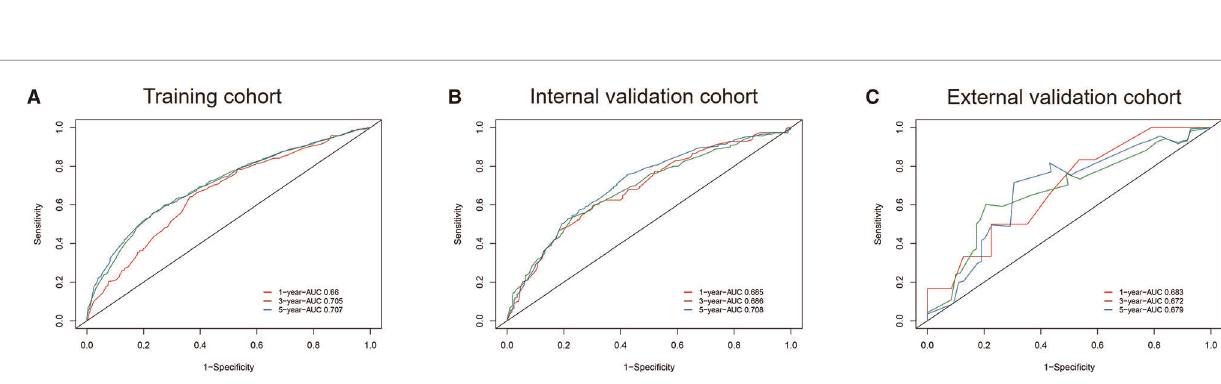
FIGURE 4 | ROC curves and AUCs at 1, 3, and 5 years in the training cohort ( A ), internal validation cohort ( B ), and the external validation cohort ( C